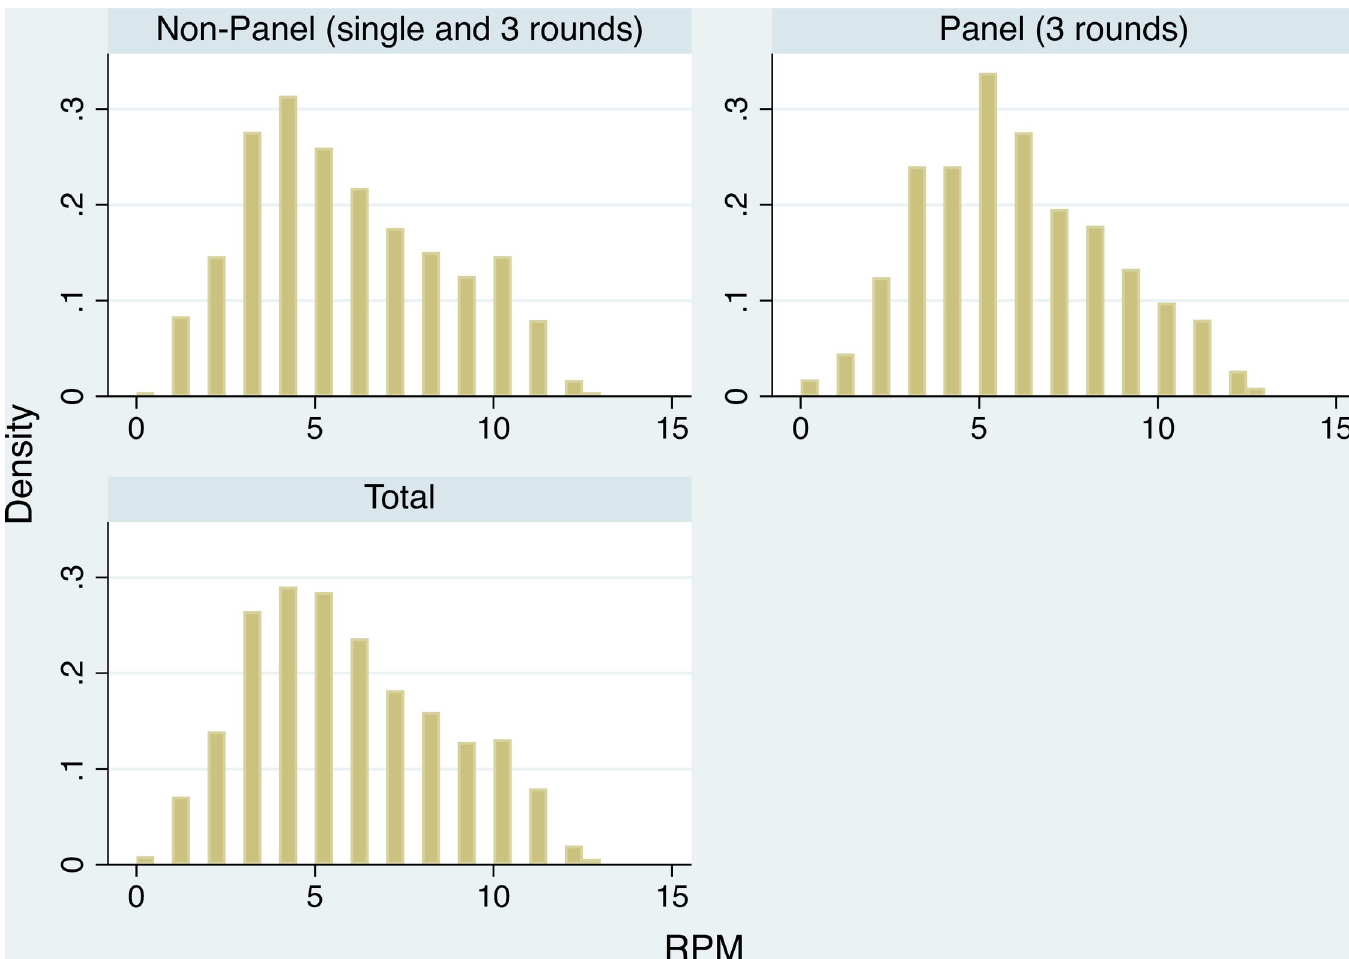
Fig 3. RPM scores–panel vs non-panel. Histogram (density) of RPM